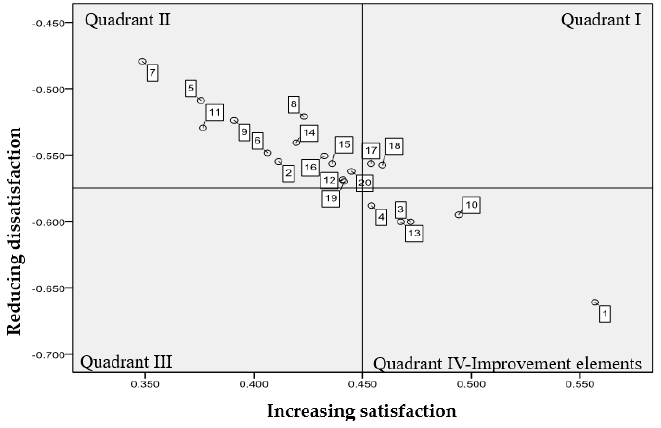
Figure 4. Kano model grid—teaching quality indicators of physical education.